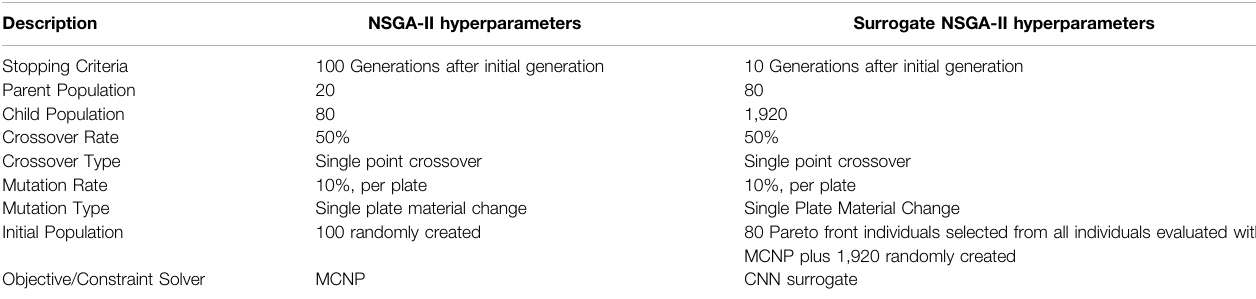
TABLE 1 | Description of NSGA-II and surrogate NSGA-II hyperparameters.